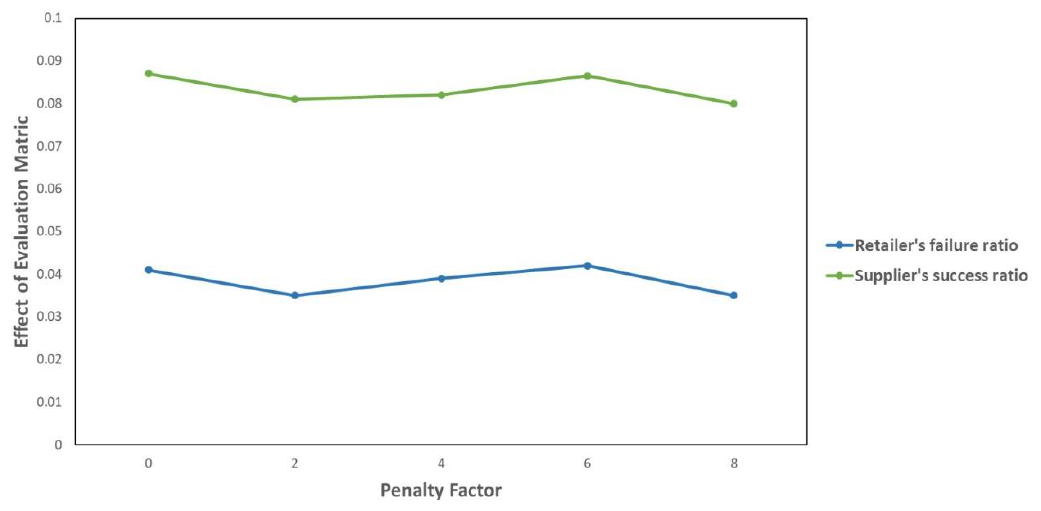
Figure 5. Effect of the penalty factor ( 𝜃 ) SSR and